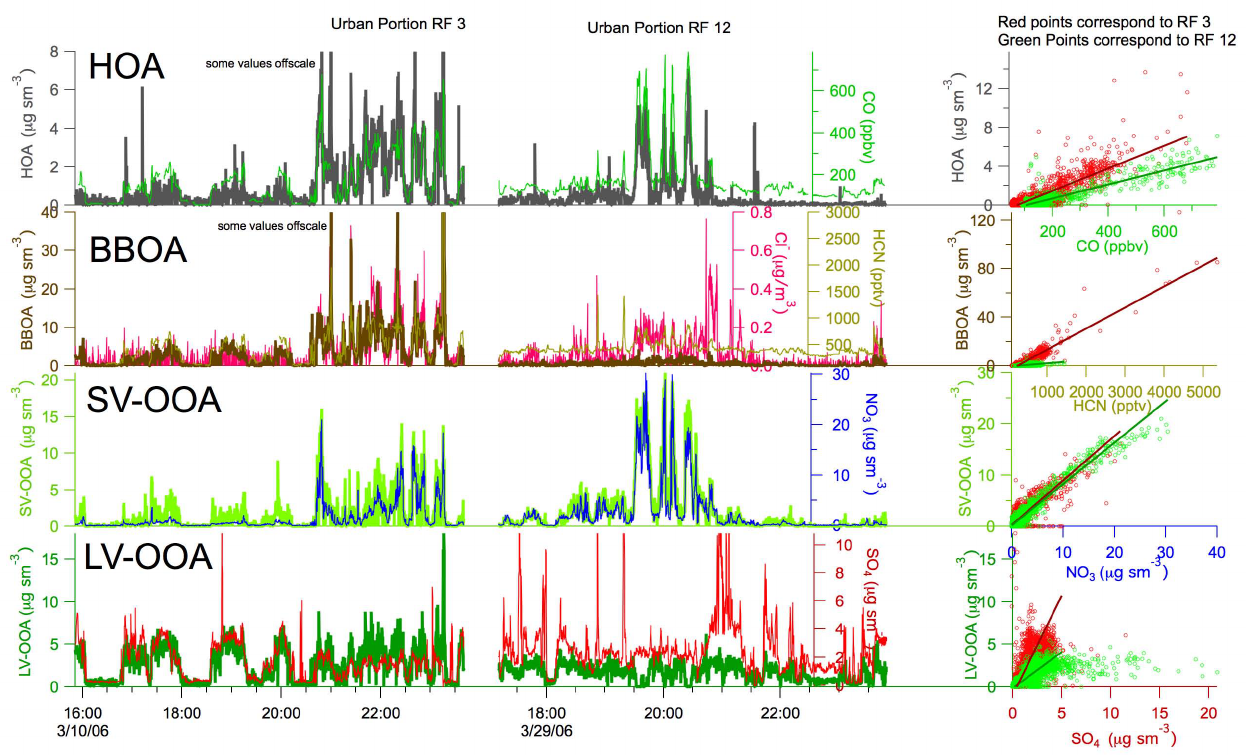
Fig. 4. Time series of the 4 factor PMF solution with tracer species for each factor. Scatter plots to the main tracers are shown to the right of the timeseries, with red points corresponding to RF3 and green points corresponding to RF12. Regression statistics of Pearson R and slope can be found in Fig.